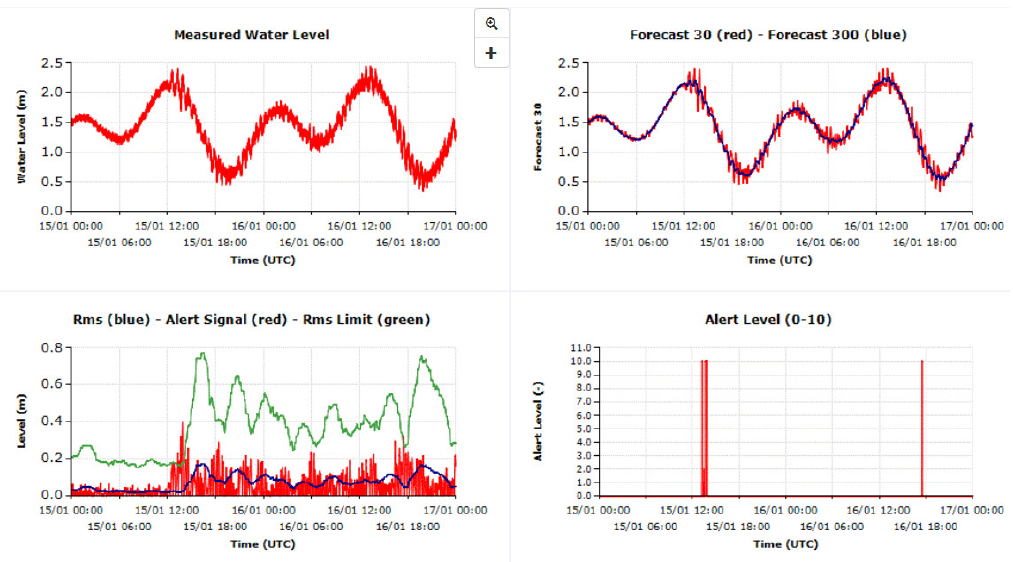
Figure 14. Figures from the TAD server website showing the passage of the pressure wave in Indonesia, Prigi caused by the explosion of the Hunga Tonga volcano, which caused a tsunami and a pressure wave propagation all over the world.